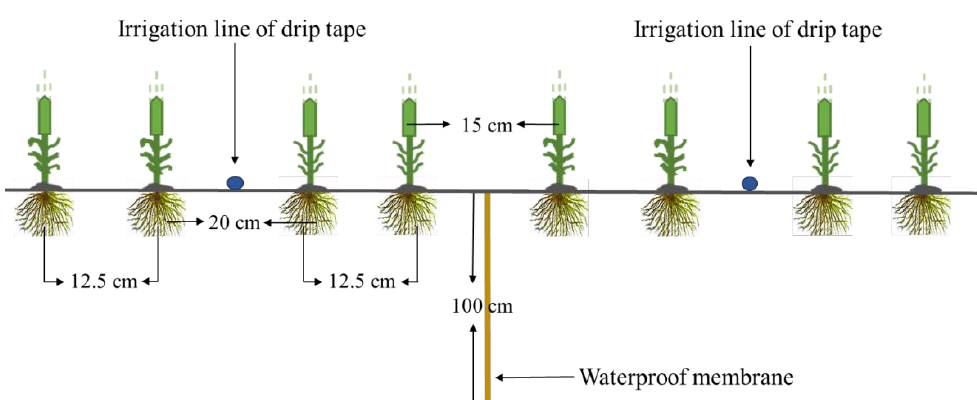
Figure 1. The relative positions of the wheat rows, the irrigation line drip tapes, and the waterproof membrane.